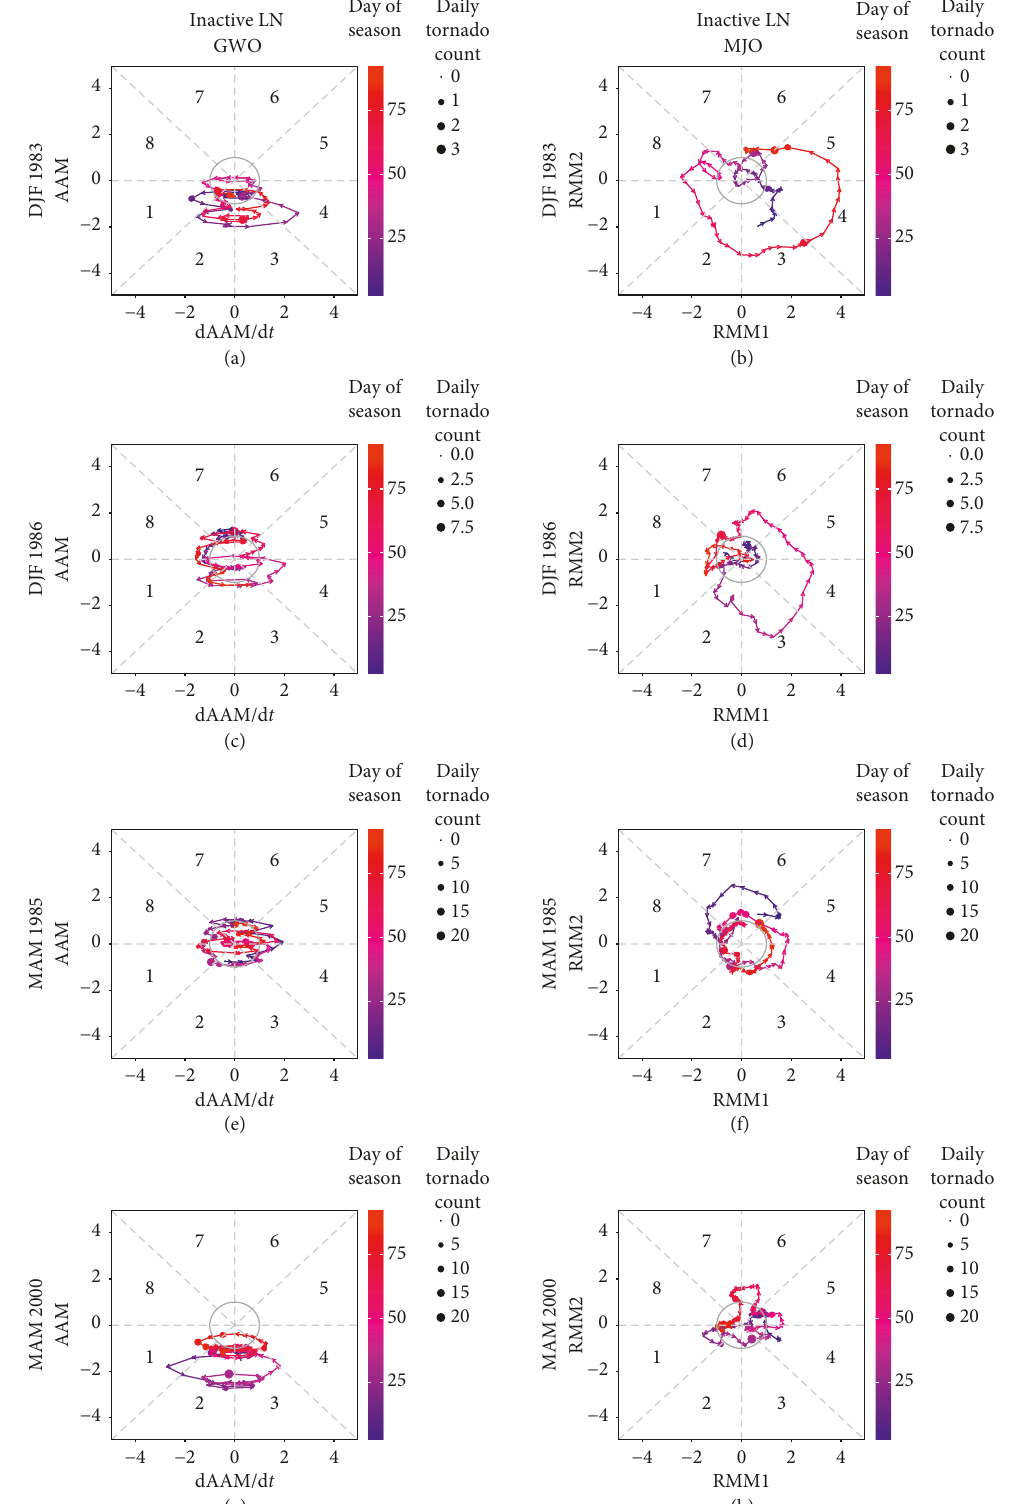
Figure 4: Phase space diagrams for the GWO (a, c, e, and g) and MJO (b, d, f, and h) during the two LN DJFs and MAMs with the fewest